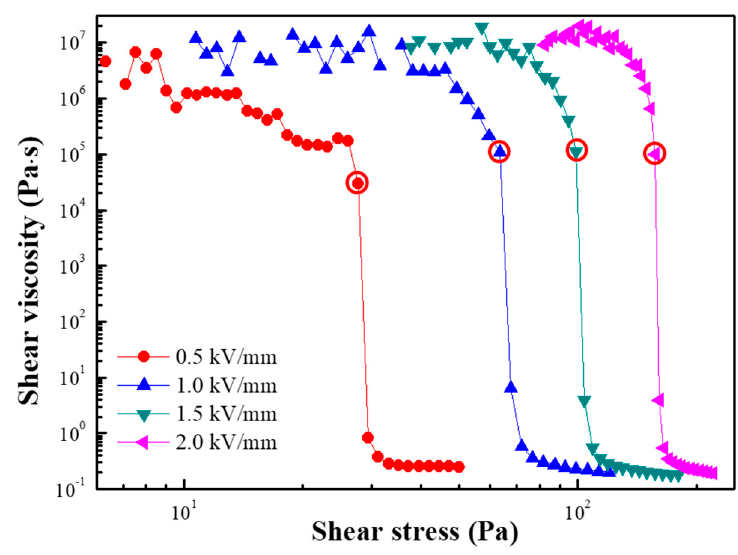
Figure 8. Shear stress-dependent shear viscosity of PDPA/Fe 3 O 4 -based ER fluid (10 vol%, 50 cSt silicone oil). The red circles label the static yield stress.